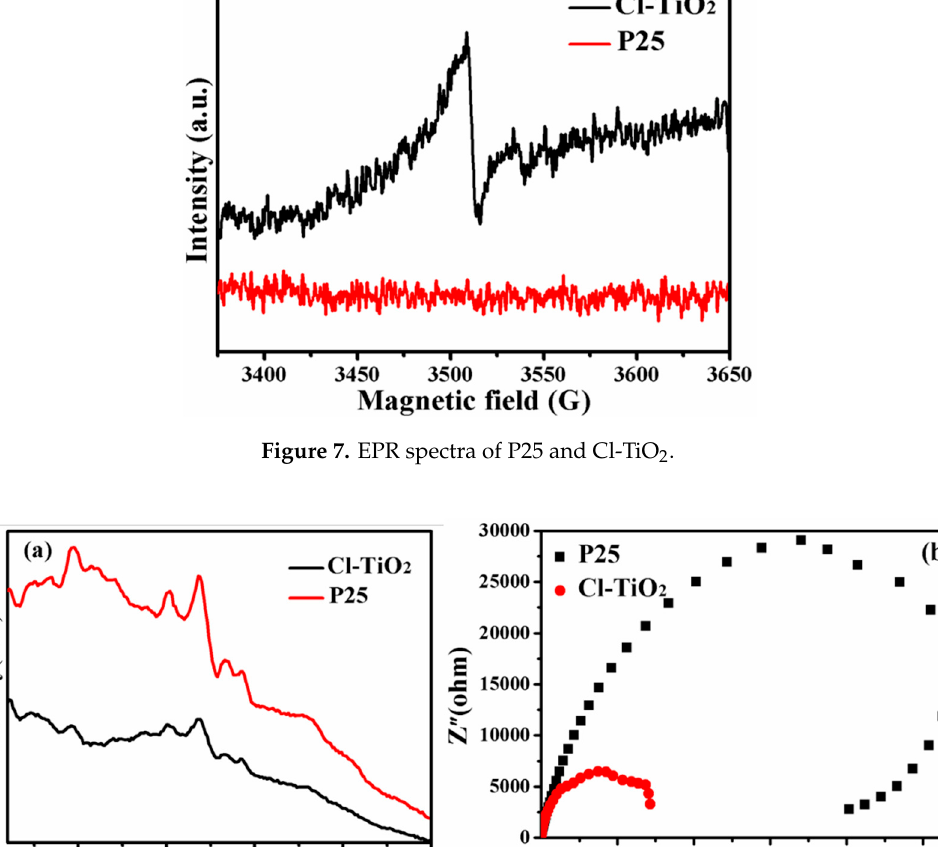
Figure 7. EPR spectra of P25 and Cl-TiO 2 .